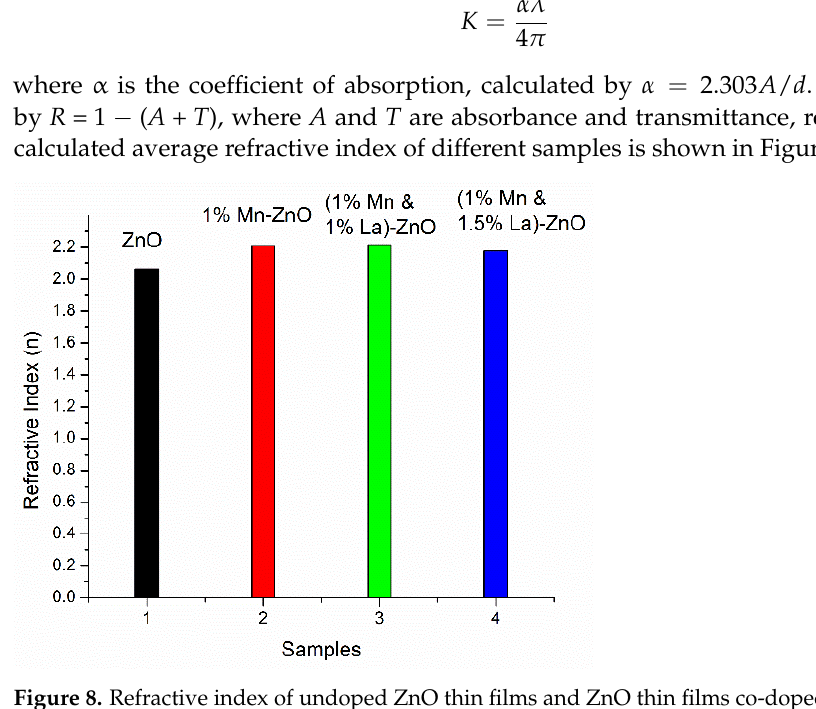
Figure 8. Refractive index of undoped ZnO thin films and ZnO thin films co-doped with Mn and